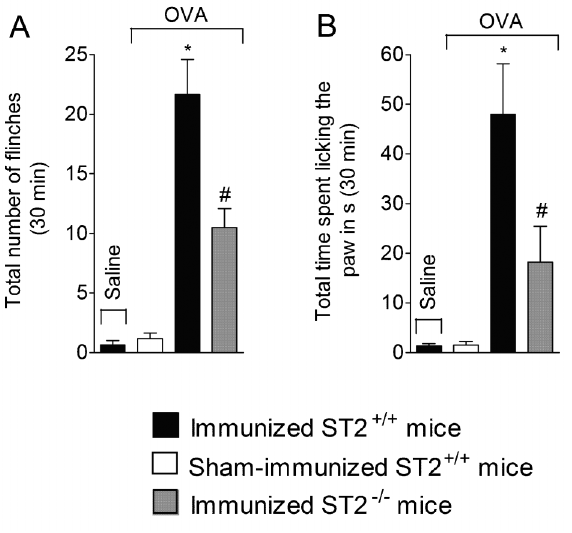
Figure 2. Role of IL-33/ST2 receptor in ovalbumin (OVA) challenge-induced overt pain-like behavior in immunized mice. ST2 +/++ and ST2 -/- mice were immunized with a single dose of 50 m g OVA plus 5 mg Al(OH) 3 diluted in saline. After 14 days, mice were challenged with 1 m g/paw OVA and the number of flinches ( A ), and time spent licking the paw ( B ) were quantified for 30 min. n=7 per group per experiment, representative of two separate experiments. *P , 0.05, immunized ST2 +/++ mice receiving OVA compared to sham-immunized ST2 +/++ mice receiving OVA and immunized ST2 +/++ mice receiving saline. # P , 0.05, immunized ST2 -/- mice receiving OVA compared to immunized ST2 +/++ mice receiving OVA (one-way ANOVA followed by the Bonferroni t